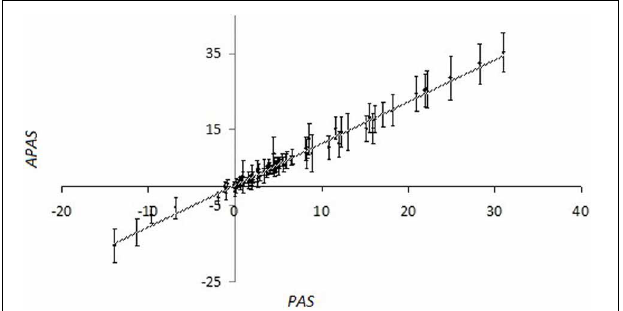
FIGURE 1 | Values of pathway activation strength ( APAS ) that were calculated using the 98 random trials, each having random log-normally distributed weighting factors w n , vs. non-perturbed PAS for the different SPs, calculated using OncoFinder method. The pathway information was extracted from the SABiosciences database. Primary data are shown on the Supplementary dataset 3. For the perturbed values ( APAS ), both average values (points at the plot) and standard deviation bars are